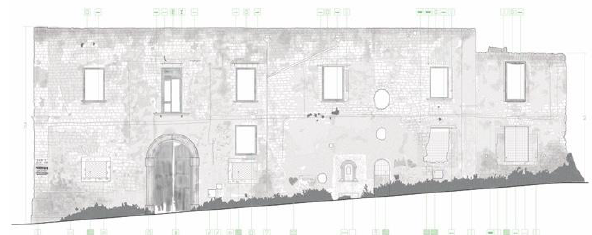
Figure 9. Conservation status of Masseria San Lorenzo : main façade. ©Restoration project of Masseria S. Lorenzo (NA), G. Coppola, M. De Rosa, F. Guarracino, M. Iengo, F. Ridente, Course or Laboratorio di Restauro architettonico, R. Picone a.a. 2018/19